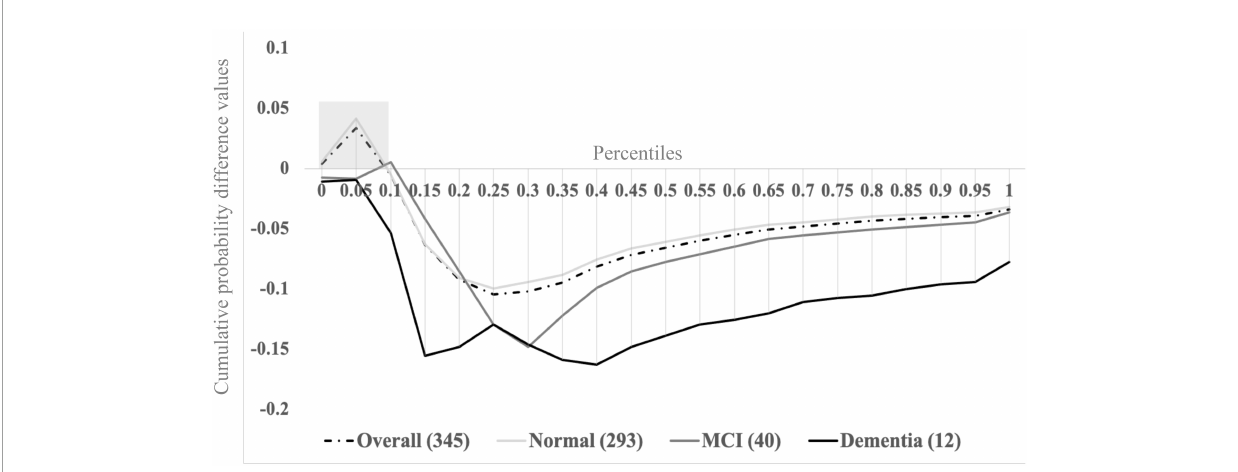
FIGURE1 Visual-somatosensory integration (VSI) cumulative probability difference waves overall and by cognitive status (normal, mild cognitive impairment, or dementia). Adapted from Mahoney and Verghese (2022). Reprinted by permission of Oxford University Press on behalf of The Gerontological Society of